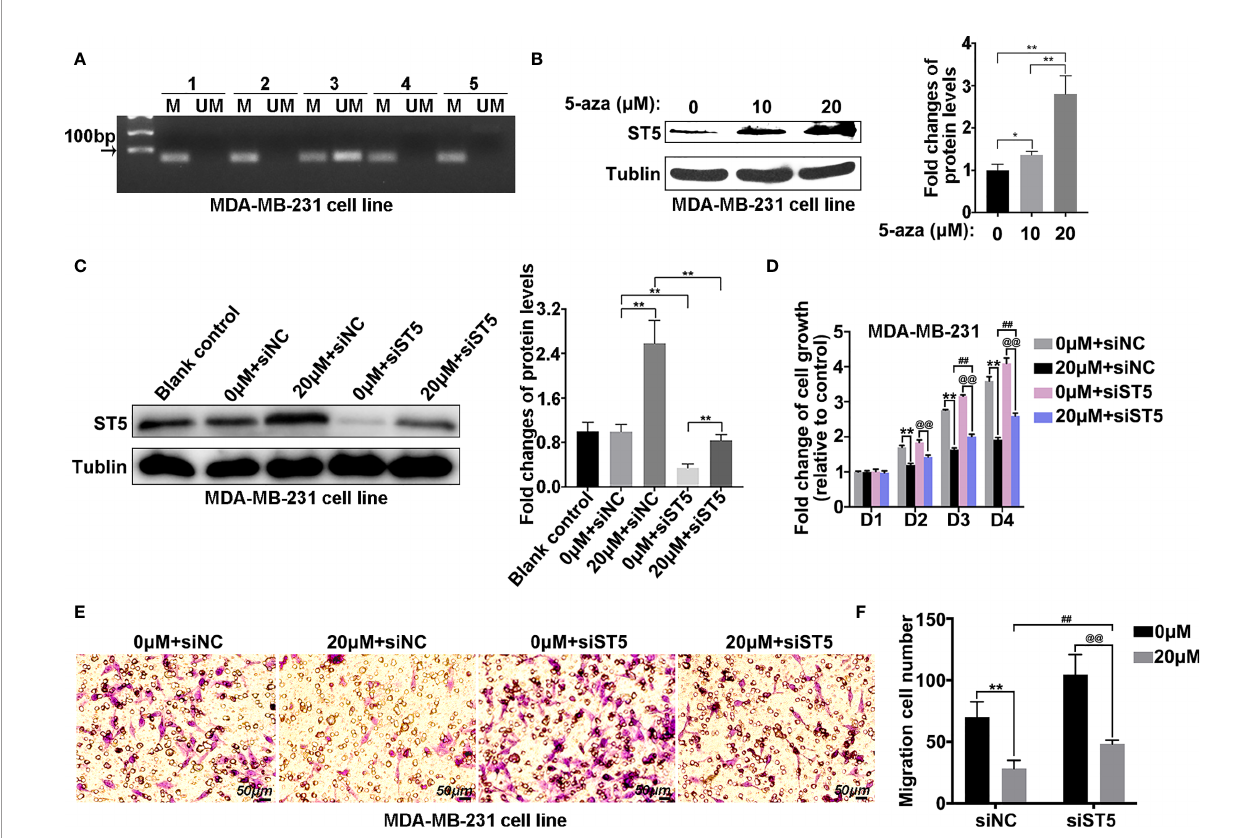
FIGURE 6 | Methylation level of the ST5 promoter region in MDA-MB-231 cells. (A) Methylation-speci fi c PCR (MSP) was performed to measure the methylation level of ST5 in MDA-MB-231 cells. The number (one to fi ve) indicated different primers used in methylation detection. (B) Protein expression of ST5 was evaluated by WB in MDA-MB-231 cells after treatment with different doses of 5-aza-dC or DMSO for 72 (h) Relative quanti fi cation of ST5 in 5-aza-dC-challenged cells as presented in the right. (C) MDA-MB-231 cells were exposed to 0 m M or 20 m M 5-aza-dC for 48 (h) Subsequently, 0 m M or 20 m M 5-aza-dC-challenged cells were transfected with negative control siRNA (siNC) or ST5-siRNA. Protein expression of ST5 as determined by WB. Relative quanti fi cation of ST5 as presented in the right. (D) MDA- MB-231 cells were transfected with negative control siRNA and siRNA targeting ST5. Subsequently, both cells were treated with 20 m M 5-aza-dC or DMSO for 72 h MTT assay was performed to measure the cell viability of MDA-MB-231 cells. (E) Transwell assay was performed to measure the cell migration of MDA-MB-231 cells treated with/without 20 m M 5-aza-dC in cells transfected with negative control siRNA and ST5-siRNA. (F) The number of migration cells as calculated by using Image Pro Plus software. M, methylation primer; UM, unmethylated primer. * indicated 20 m M 5-aza-dC-treated control cells vs. DMSO-treated control cells; # indicated 20 m M 5-aza-dC-treated siST5 group vs. 20 m M 5-aza-dC-treated control group; @ indicated 20 m M 5-aza-dC-treated siST5 group vs. DMSO-treated siST5 group. **, ##, @@, P <